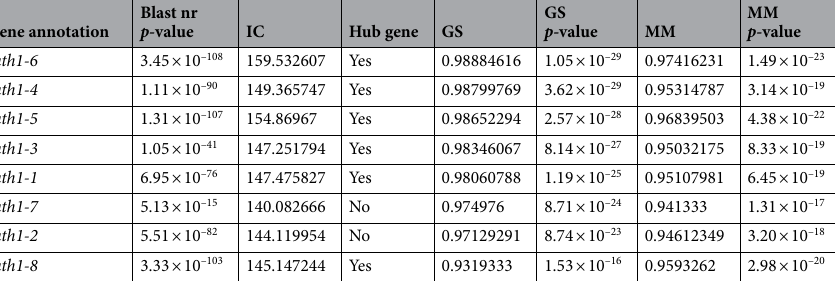
Table 2. Genes in the pink module that have high homology to CATH1 and the top 30 highest IC or GS